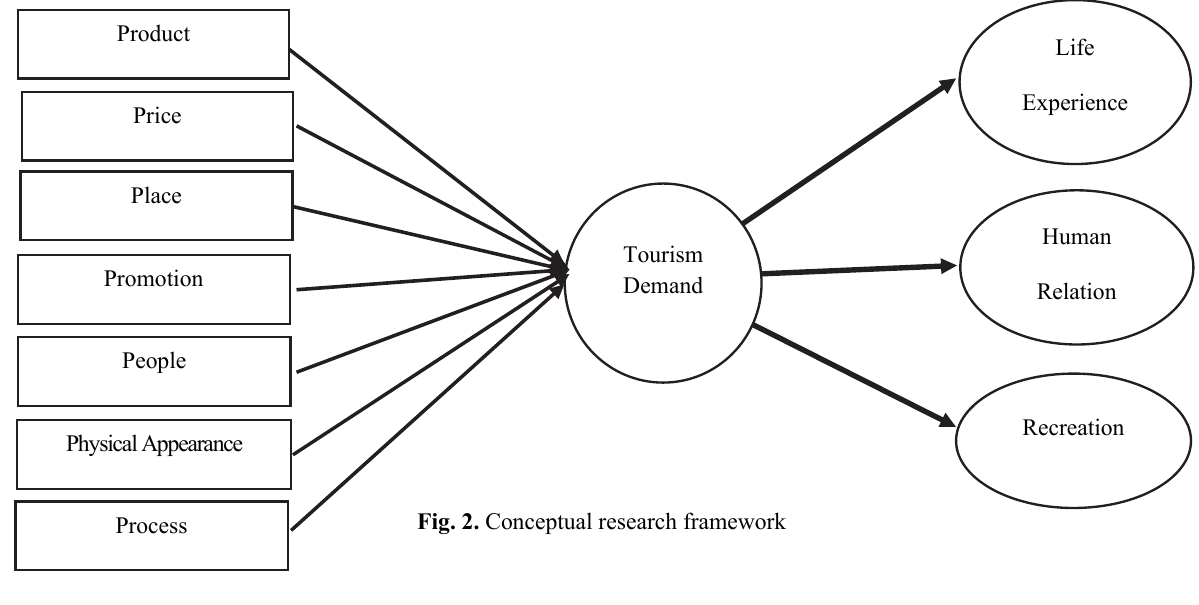
Fig. 2. Conceptual research